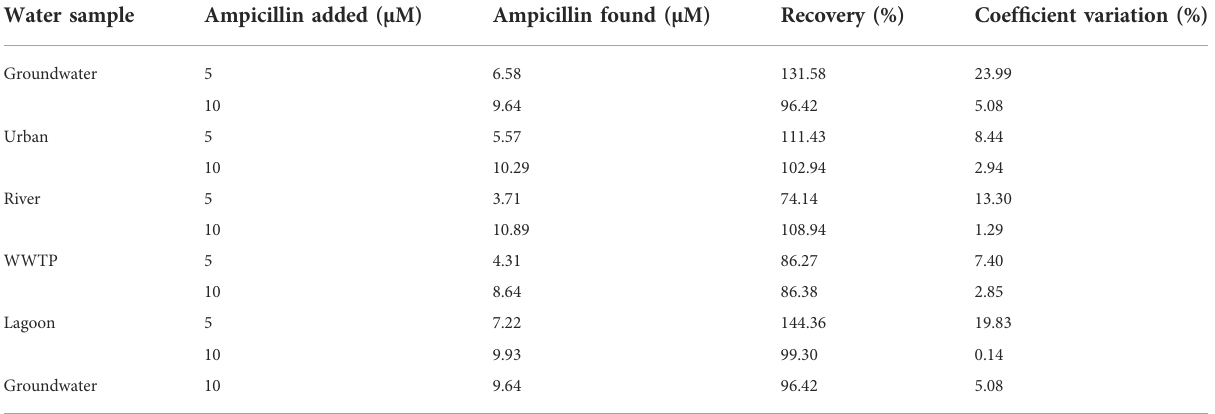
TABLE 5 Analysis of ampicillin in spiked environmental water samples by the proposed biocatalytic method. Water